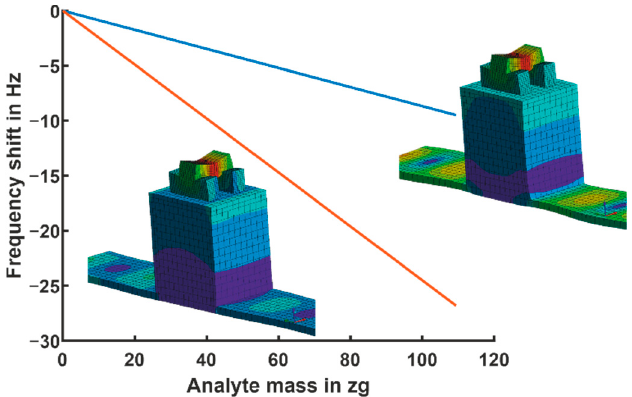
Figure 11. Absolute frequency change of ( ω L − ω L,0 ) / ( 2 π ) and ( ω H − ω H,0 ) / ( 2 π ) due to an analyte mass attached to the top center of the nano-beam and corresponding coupled eigenmodes.